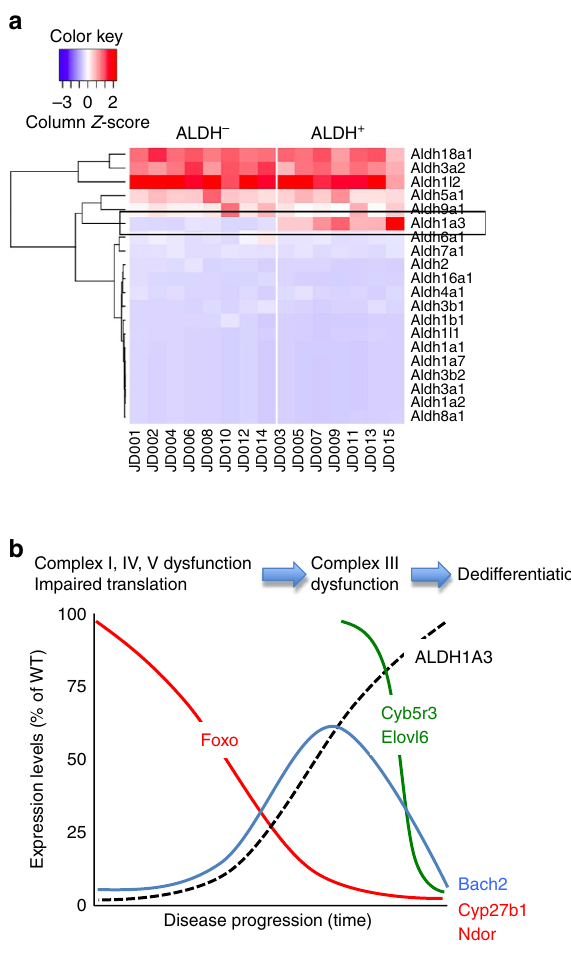
Figure 5 | Comprehensive analysis of ALDH isoform expression in flow-sorted ALDH þ and ALDH (cid:3) cells. ( a ) Data from RNA sequencing of all ALDH transcripts are represented as column Z -scores, with red indicating high expression and blue indicating low expression. Each row represents a different ALDH isoform, and each column an individual sample used for analysis. RFP þ ALDH (cid:3) : JD001 through JD014, and RFP þ ALDH þ : JD003 through JD015. Aldh1a3 is boxed for reference. ( b ) Model of the relationship between changes in Foxo levels and gene expression signature of ALDH þ cells.